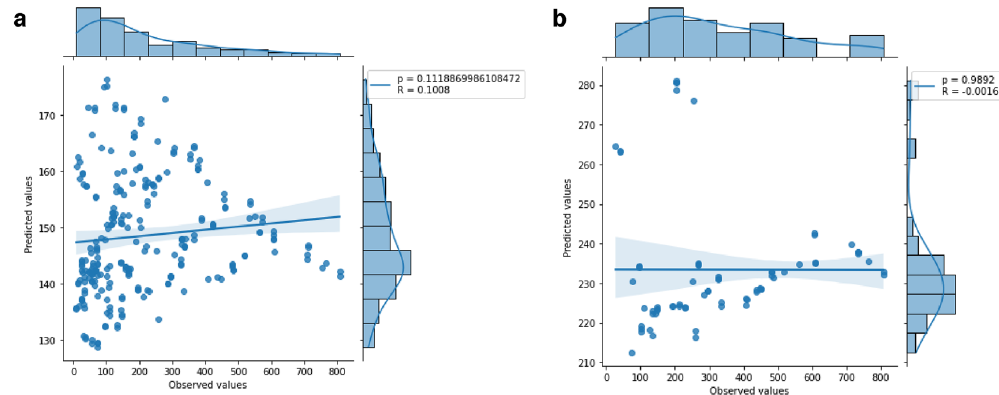
Figure 7. Pearson correlation between predicted and observed values. ( a ) Correlation from the model with the lowest MSE in the 3T3 cell line. ( b ) Correlation based on the model with the highest